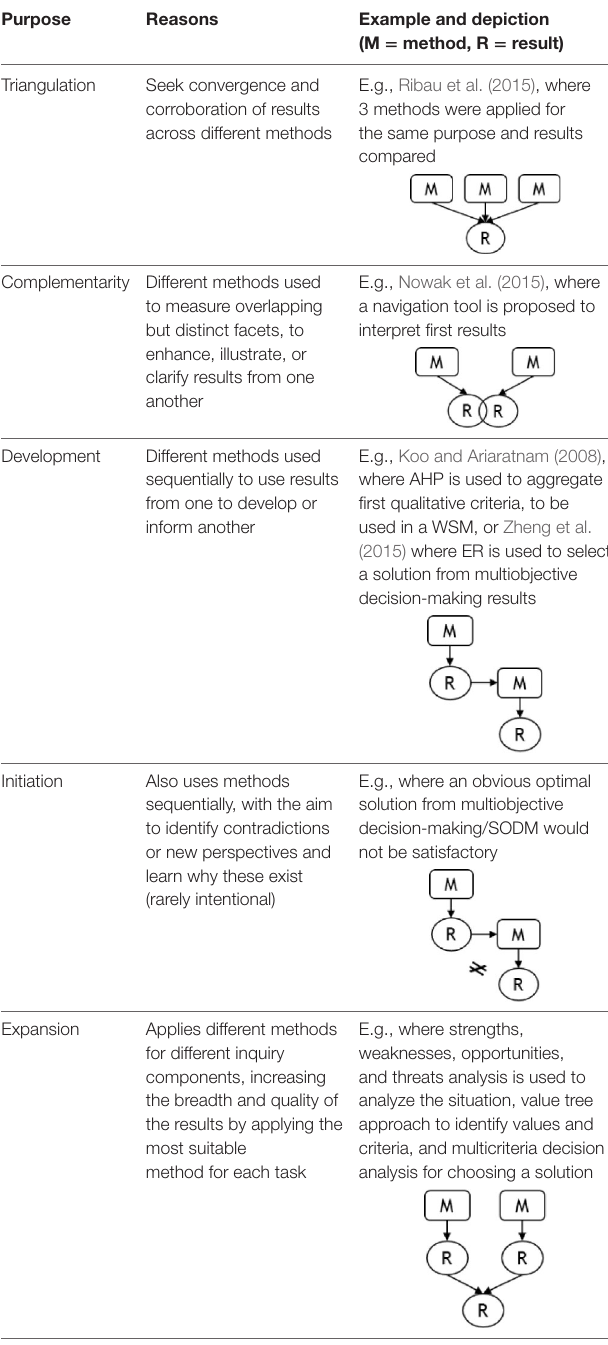
TABLe 1 | Purposes for combining multiple methods.